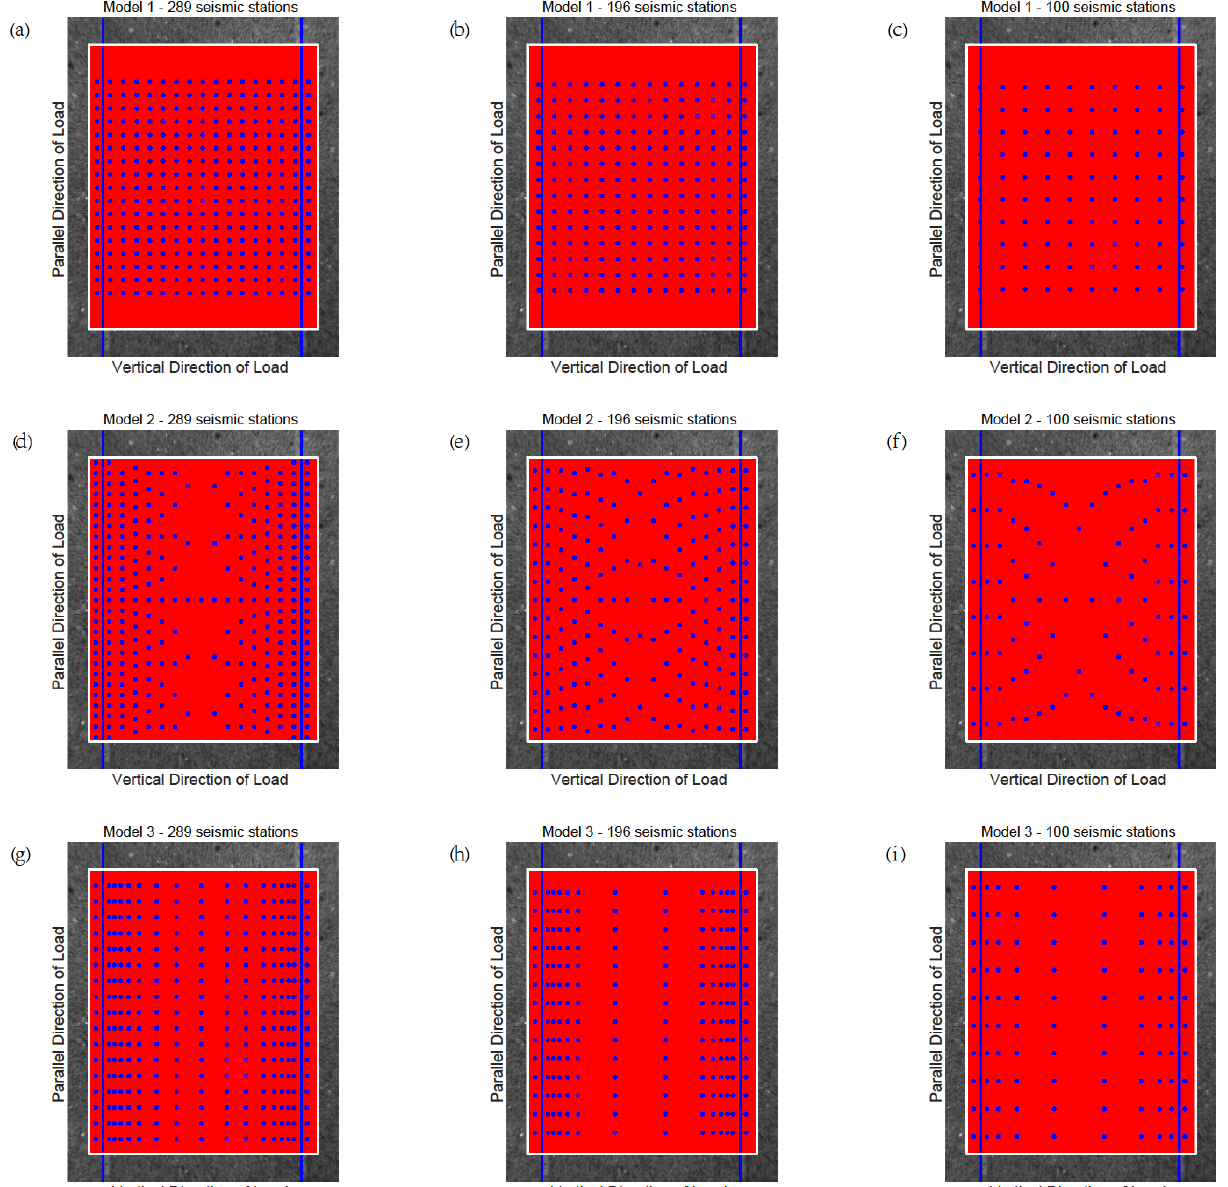
Figure C4. Three kinds of seismic monitoring models with different numbers of seismic monitoring stations for sample